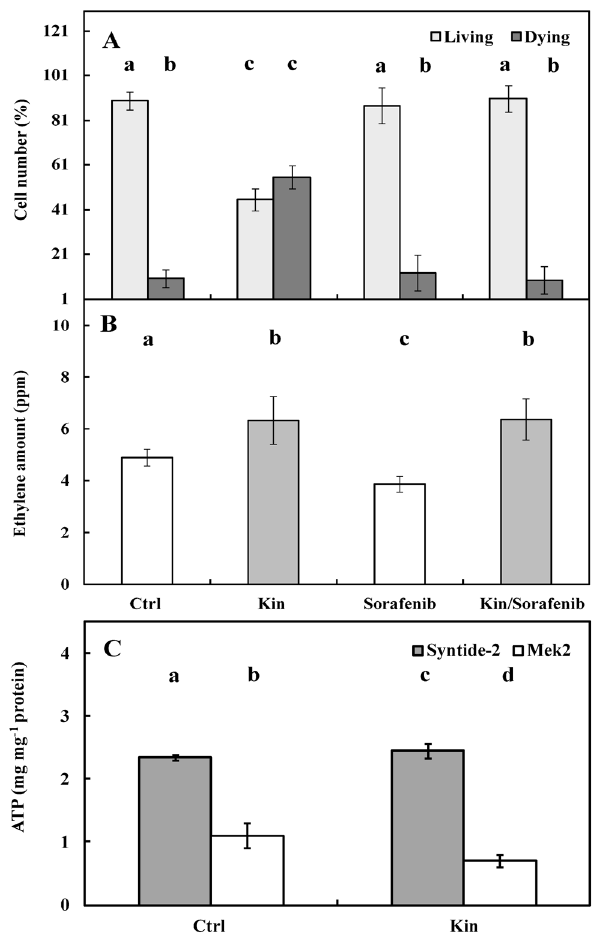
Figure 8. The number (%) of living and dying cells ( A ), ethylene amounts after treatment with Sorafenib ( B ) and CTR1/RAF-like and mitogen-activated protein kinase 2 (MEK2) activities with Syntide-2 and Mek2 substrate, respectively ( C ), in apical roots of Vicia faba ssp. minor seedlings treated with kinetin (Kin) for 72 h. The number of living and dying cells as well as the amounts of Ca 2+ were fluorescently estimated after staining with acridine orange, ethidium bromide and chlortetracycline. Kinase activities were determined using the luciferase technique and ATP as a substrate. Bars indicate ± SE of the results from three biological replicates. The means of the results with the same letter above the column are not significantly different at p ≤ 0.05. Ctrl, control; Kin, kinetin; Sorafenib, RAF kinase inhibitor; sorafenib with Kin, Kin/Sorafenib; Syntide-2, synthetic